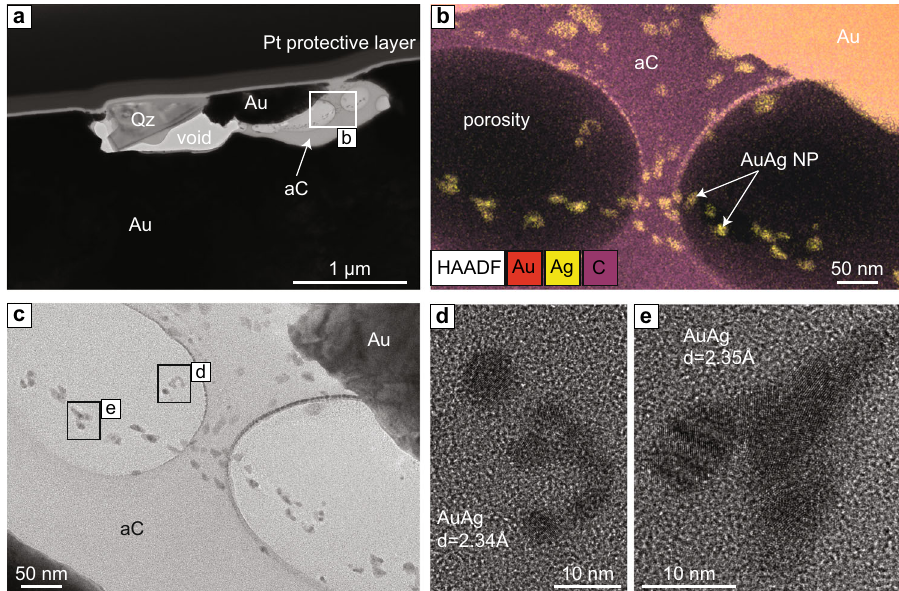
Fig. 2 Red Lake electrum nanoparticles in amorphous carbon. a High-Annular Dark Field Scanning Transmission Electron Microscopy (HAADF-STEM) image of the Red Lake foil showing elongated inclusion at the surface of the foil, mainly composed of quartz (Qz) and an amorphous carbon phase (aC); the rest of the foil comprises coarse gold; the top of the foil is covered by a protective platinum (Pt) layer. b Energy-dispersive X-ray spectroscopy (EDS) elemental map overlaying a HAADF-STEM image from the middle of the inclusion, indicated by white rectangle in Fig. 2a; electrum nanoparticles (NPs) are encapsulated in a carbon-rich phase. c TEM image of the area marked by white rectangle in Fig. 2a; the inclusion is composed of an amorphous carbon phase (light grey) containing sub-rounded NPs (darker grey). Two large, “ bubble ” -like features correspond to cavities within the amorphous phase. d , e High Resolution TEM (HRTEM) image of areas marked by black rectangles in Fig. 2c showing electrum NPs with sizes varying from 4 to 10 nm. The FFT collected from the largest NP con fi rms a d-spacing of 2.34 Å, corresponding to Ag or Au or Ag-Au